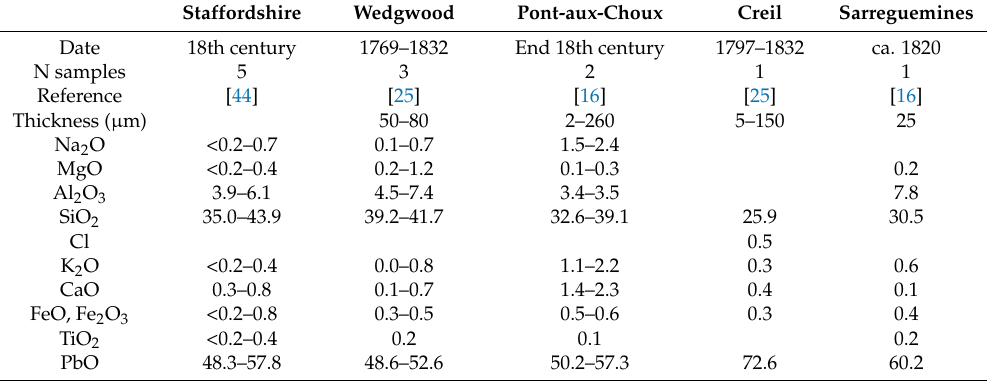
Table 3. Thicknesses and scanning electron microscope-energy-dispersive X-ray spectroscopy (SEM-EDS) analyses (wt %) of transparent glazes of English and French CaO poor white earthenwares